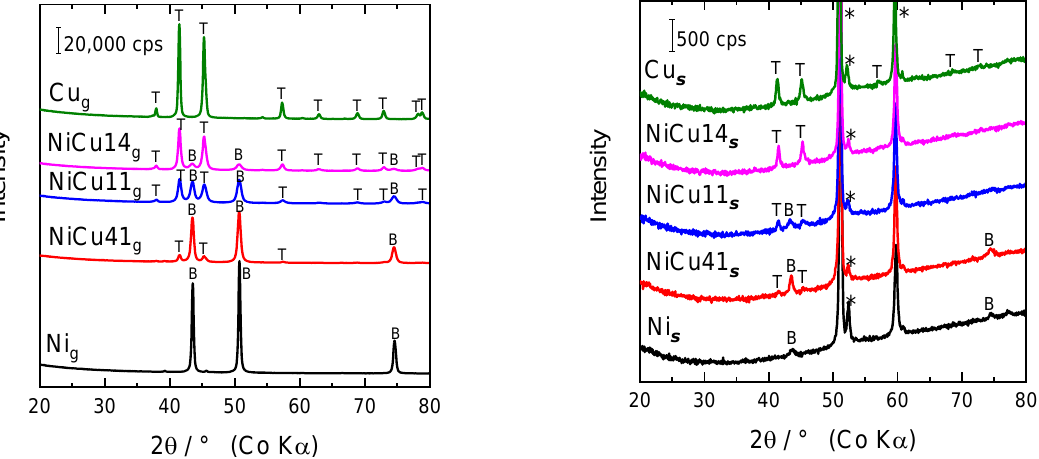
Figure 2. Powder XRD patterns of granular ( left ) and sputtered ( right ) Ni-Cu oxide catalysts; B–NiO (bunsenite), T—CuO (tenorite), *—stainless steel support.